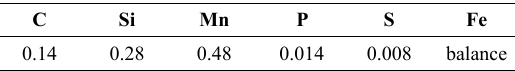
Table 1. Chemical compositions of experimental steel